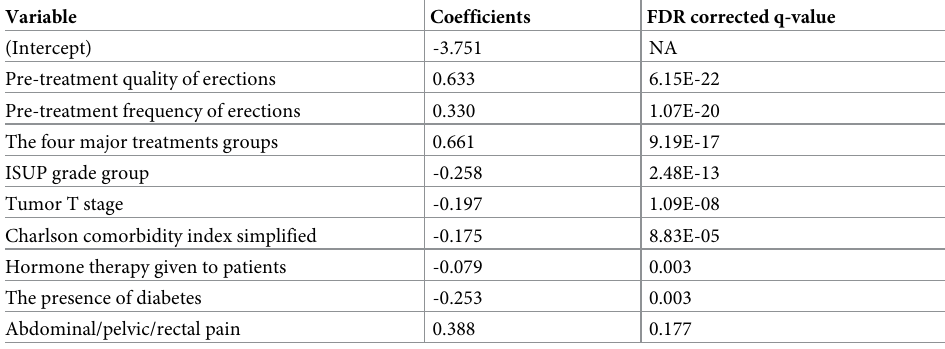
Table 3. The logistic regression coefficients of the input variables in the 2-year outcome prediction model. In addition, the univariate FDR-corrected q-value is reported for each variable.